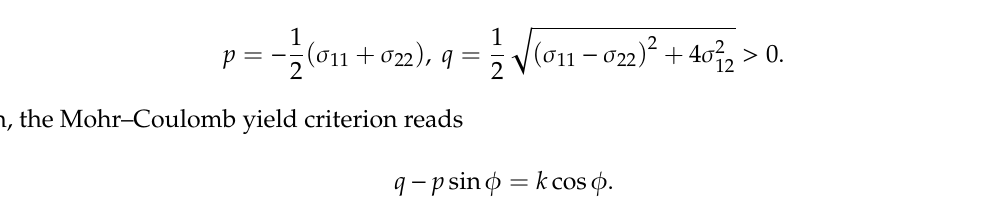
Figure 1. Orthogonal coordinate system ( x 1 , x 2 ) near a given curve (S–line) under plane strain conditions.